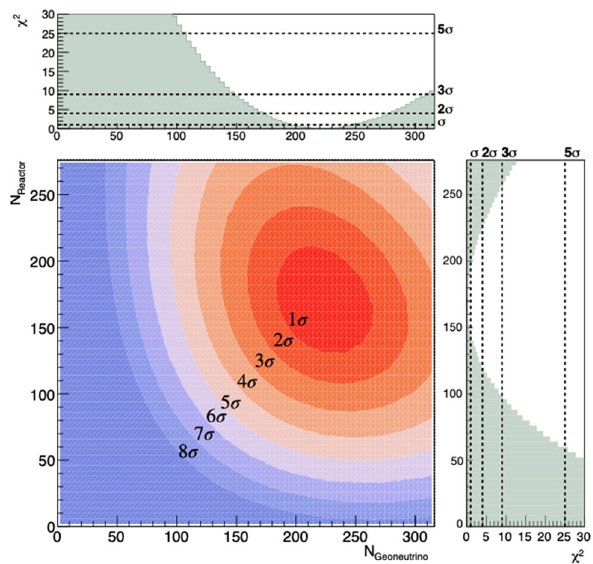
Fig. 8 2-D confidence level of the geoneutrino versus reactor antineu- trinos flux after one year of data taking, estimated with 1000 toy exper- iments (statistical uncertainties only). The confidence level are drawn for [ 1 σ, 8 σ ] . The individual projection for each contribution at the best fit position is also shown with the statistical significance as dashed